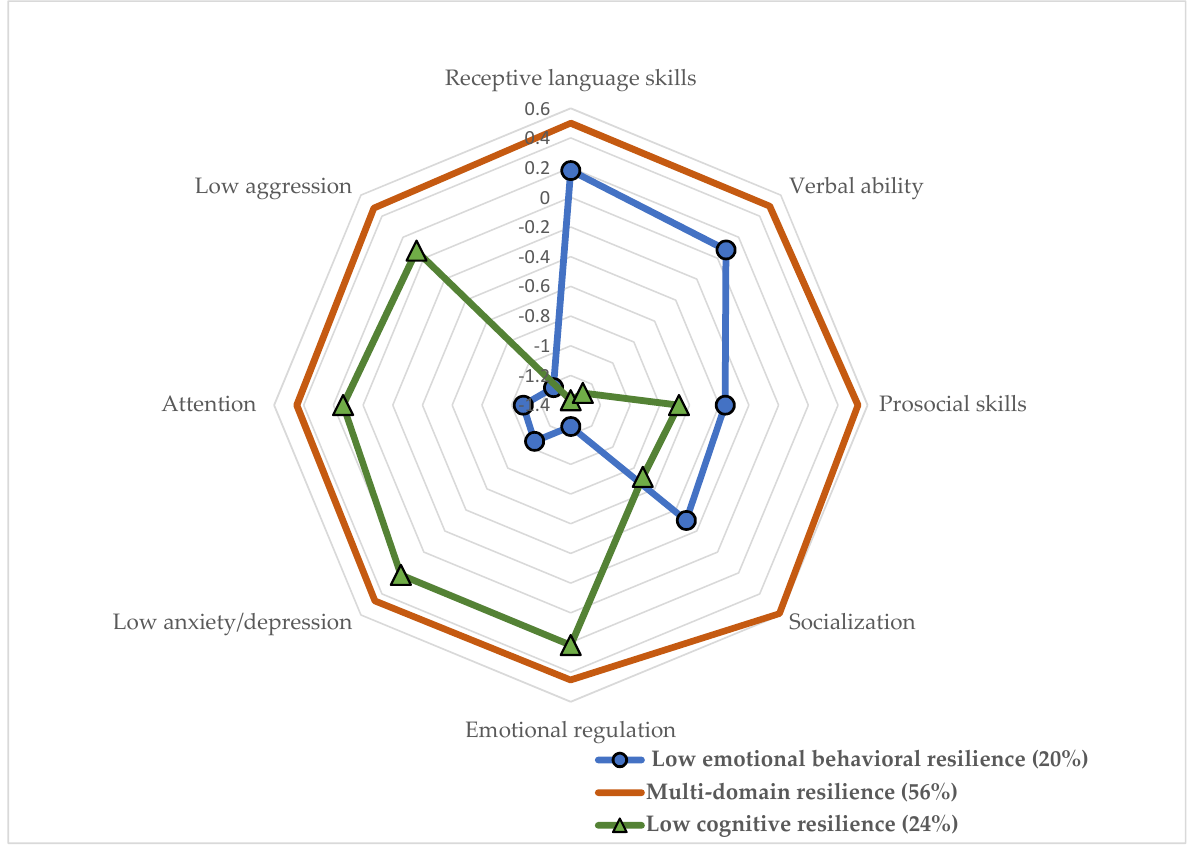
Figure 1. Radar Chart of Early Childhood Resilience Profiles. Note. Adapted from [2]. z-scores ( M = 0, SD = 1) of the resilience indicators were used for the radar chart for interpretability purposes.